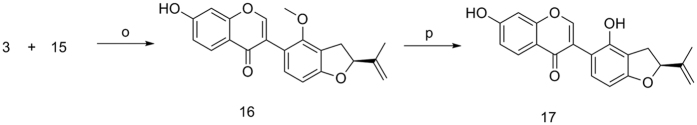
Synthesis of CHF C.Reagents and conditions: (o) 1,4-dioxane, Pd(dppf)Cl2, 1 N Na2CO3 (aq), 50 °C; (p) DMF, sodium ethanethiolate, 100 °C.